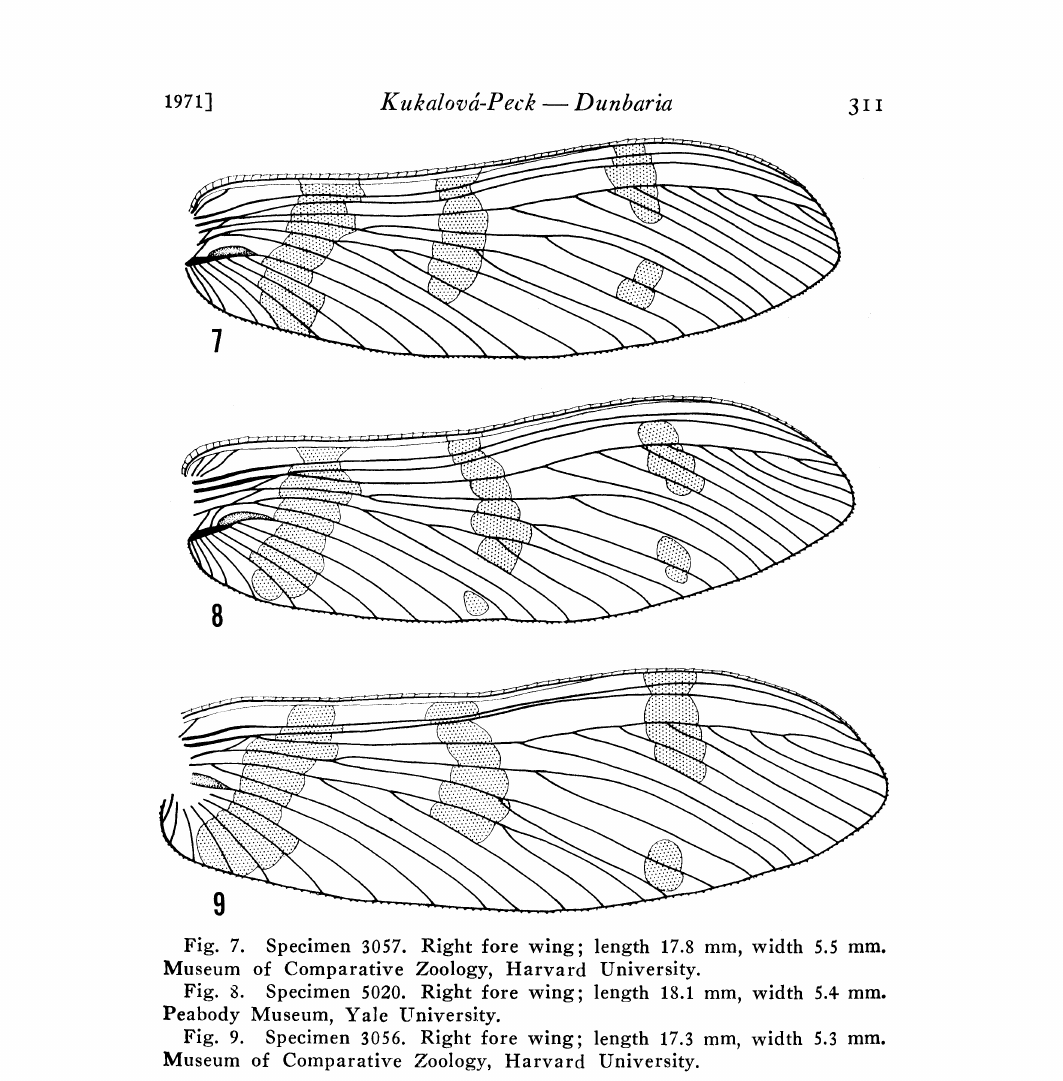
Fig. 7. Specimen 3057. Right fo, re wing; length 17.8 mm, width 5.5 mm. Museum of Comparative Zoology, Harvard University. Fig. 8. Specimen 5020. Right fore. wing; length 18.1 mm, width 5.4 mm. Peabody Museum, Yale University. Fig. 9. Specimen 3056. Right fore wing; length 17.3 mm, width 5.3 mm. Museum of Comparative Zoology, Harvard